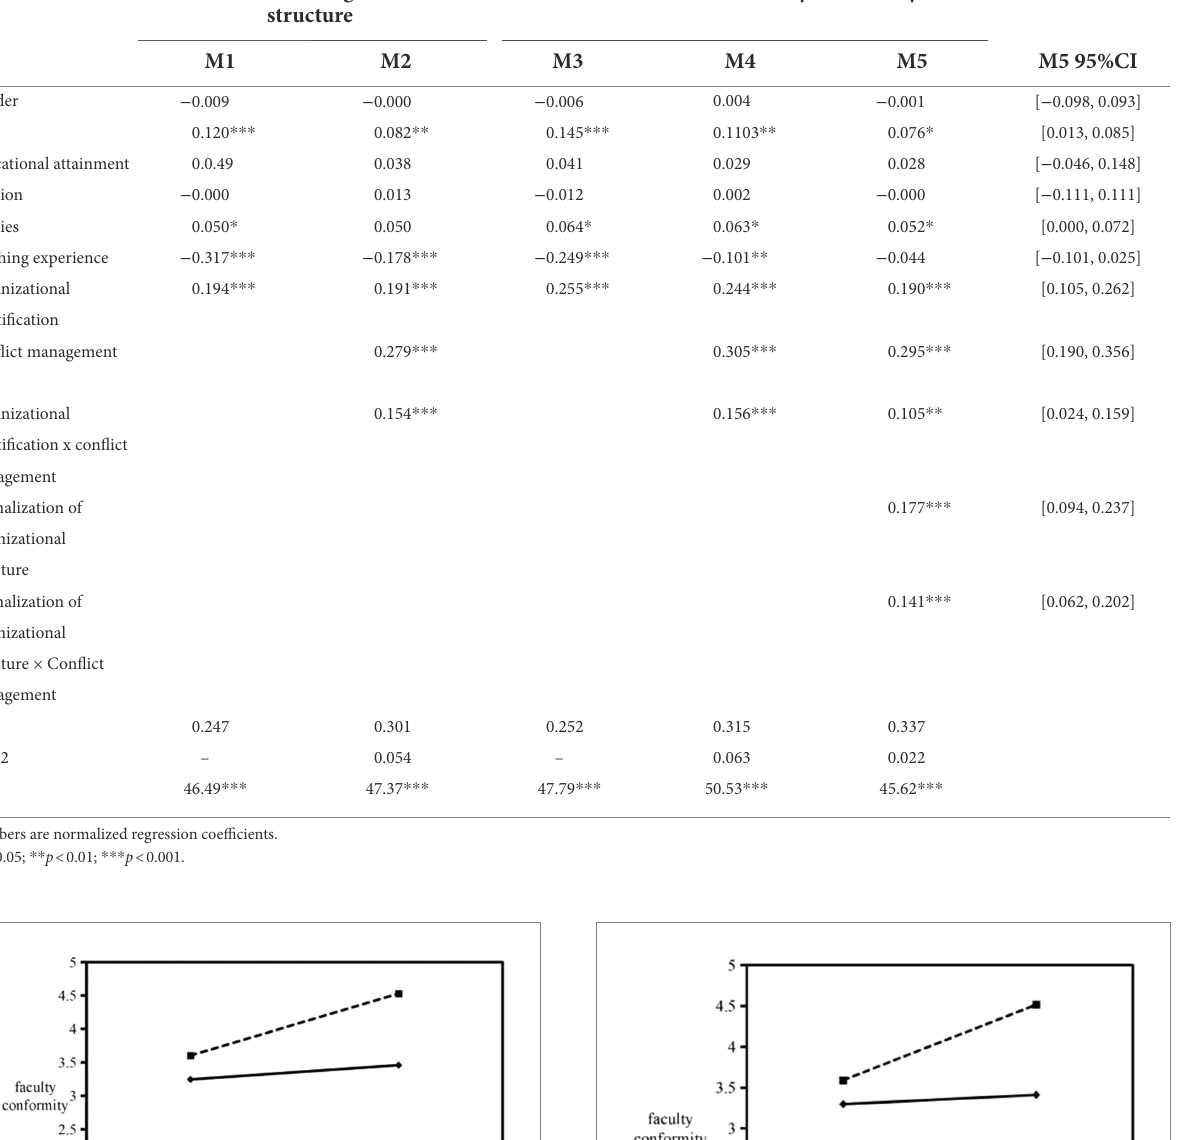
TABLE 2 Summary of regression analysis of moderated mediation.